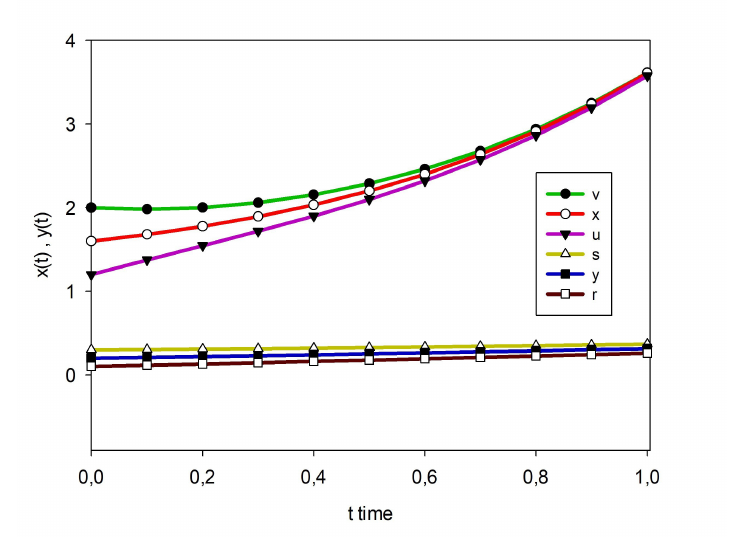
Fig. 3 Crips solution and fuzzy solution for α = 0.